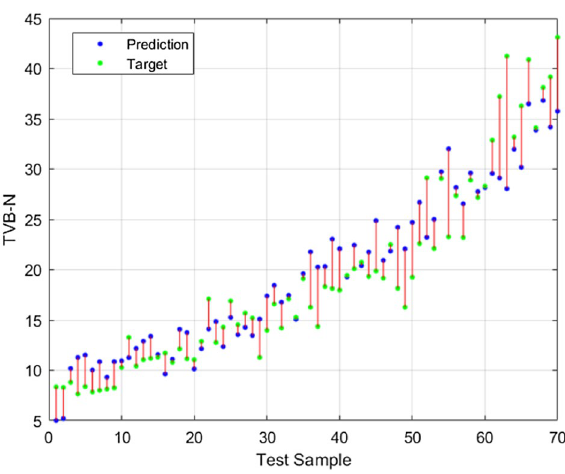
Figure 4. Regression results of LDNN for 70 samples of prediction